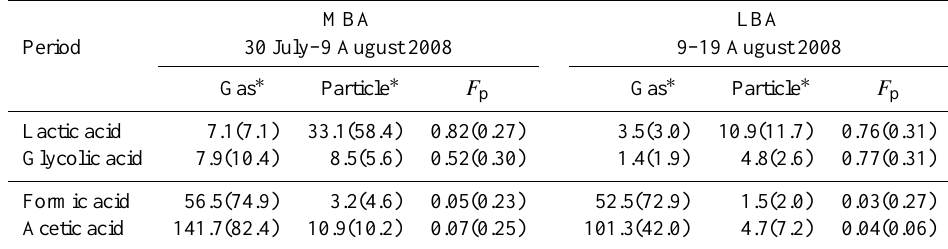
Table 1. Concentrations of lactic, glycolic, formic, and acetic acids together with their particle-phase fraction ( F p ) during the periods when more biologically influenced aerosols (MBAs) and less biologically influenced aerosols (LBAs) were observed aboard the R/V Hakuho- Maru . The values are means with standard deviations in